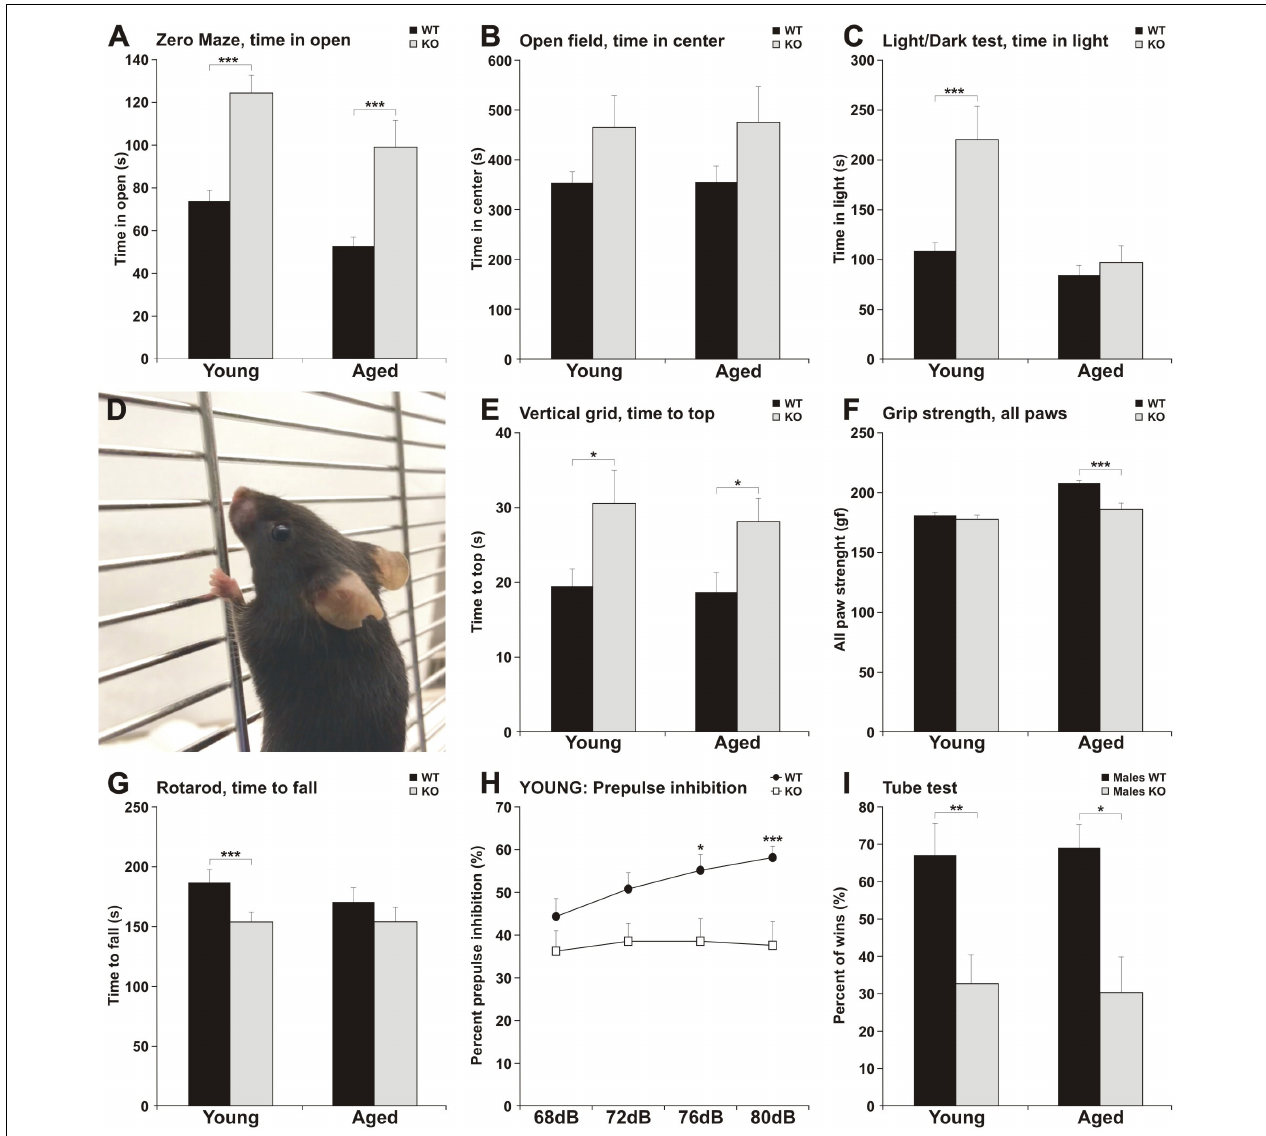
FIGURE 2 | MIM KO mice exhibit altered behavior in various tests. (A–C) MIM KO mice had reduced anxiety and spent more time exploring the open arms of zero maze (A) , the center of the open field arena (B) and the light compartment of light/dark test (C) compared to WT littermates. (D–G) MIM KO mice exhibited motor coordination impairment in vertical grid test - representative picture of mouse climbing to the top of the grid (D) and time taken to climb to the top of the grid (E) , grip strength - five trials average was compared between groups (F) , latency to fall on the rota-rod task (G) . (H) Pre-pulse inhibition defect in MIM KO mice. (I) Percentages of the wins in the tube test. ∗ denotes statistical significance: ∗ p < 0.05, ∗∗ p < 0.01, ∗∗∗ p <